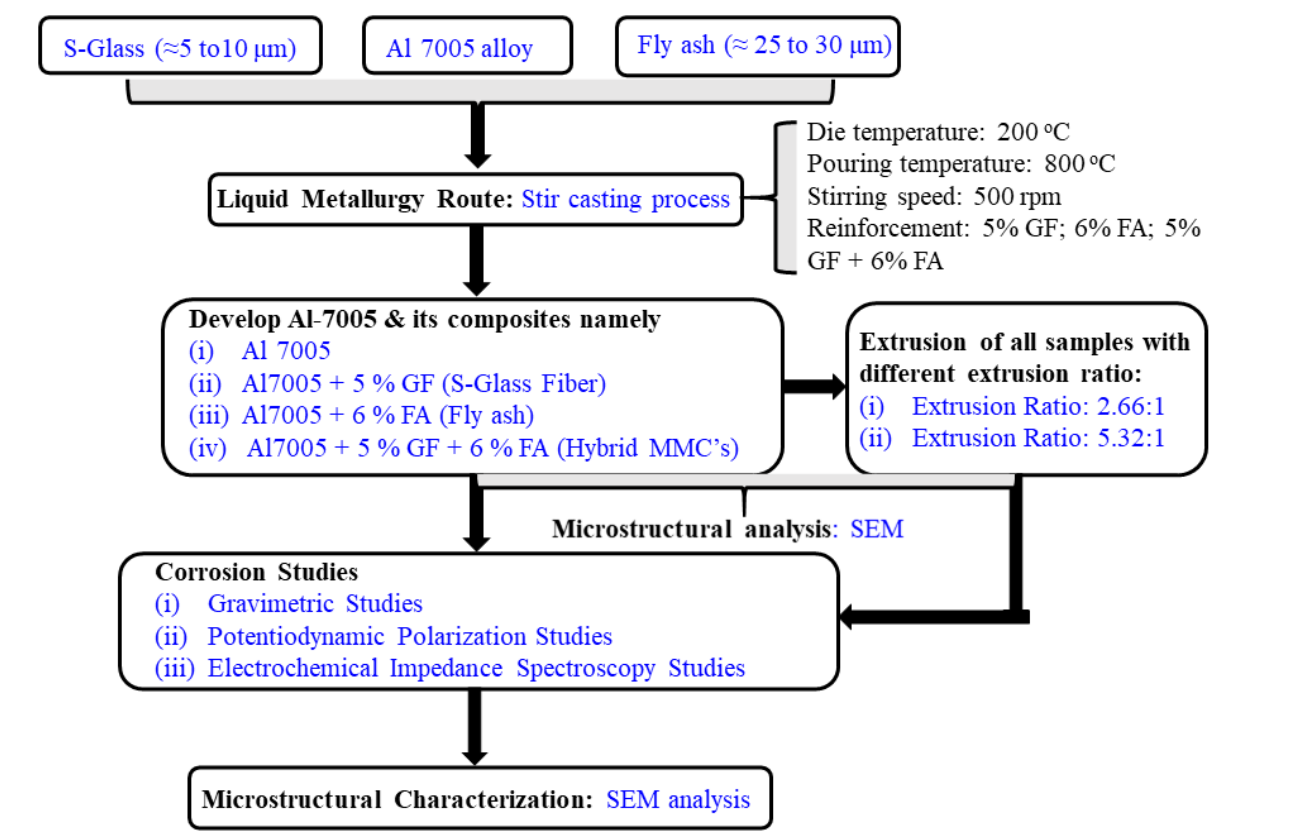
Figure 2. Flowchart illustrating the steps involved in the characterization of stir casting and extruded parts.